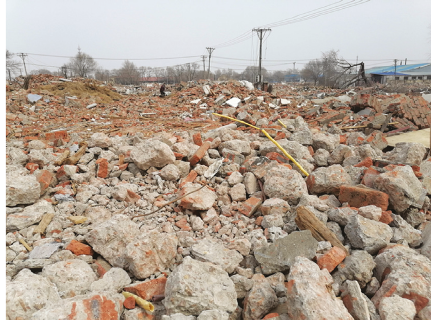
Figure 1: Appearance of construction waste.